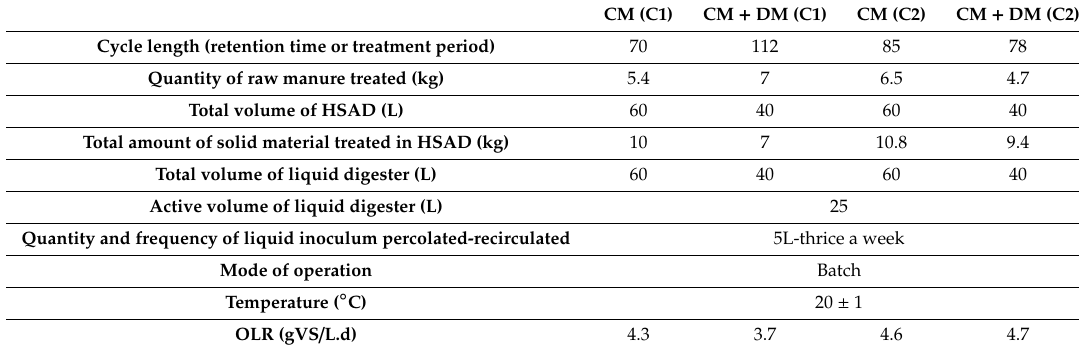
Table 2. Operating conditions of mono-digestion (CM) and co-digestion (CM + DM). CM (C1) CM + DM (C1) CM (C2) CM + DM (C2) Cycle length (retention time or treatment period) 70 112 85 78 Quantity of raw manure treated (kg) 5.4 7 6.5 4.7 Total volume of HSAD (L) 60 40 60 40 Total amount of solid material treated in HSAD (kg) 10 7 10.8 9.4 Total volume of liquid digester (L) 60 40 60 40 Active volume of liquid digester (L) 25 Quantity and frequency of liquid inoculum percolated-recirculated 5L-thrice a week Mode of operation Batch Temperature ( ◦ C) 20 ± 1 OLR (gVS / L.d) 4.3 3.7 4.6